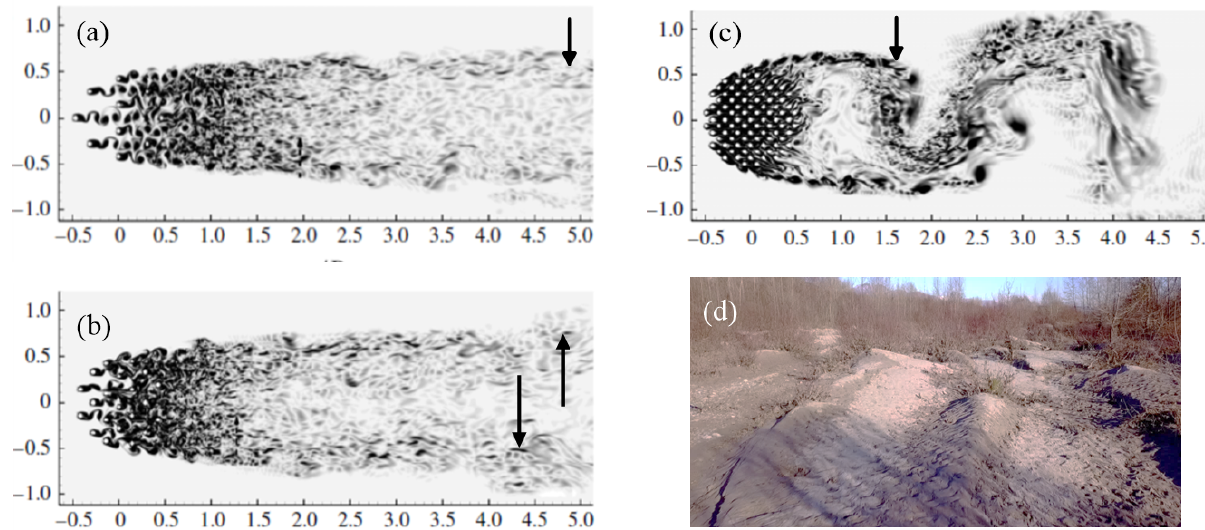
Figure 1. Patterns of vorticity behind a porous obstruction as a function of solid volume fraction (a) (cid:56) = 0 . 023, (b) (cid:56) = 0 . 05, (c) (cid:56) = 0 . 2 (reproduced with permission from Chang and Constantinescu, 2015; the arrows indicate the location of vortex shedding) and (d) the half- lemniscate shaped tale bars behind patches of riparian vegetation on the floodplain of the Tagliamento